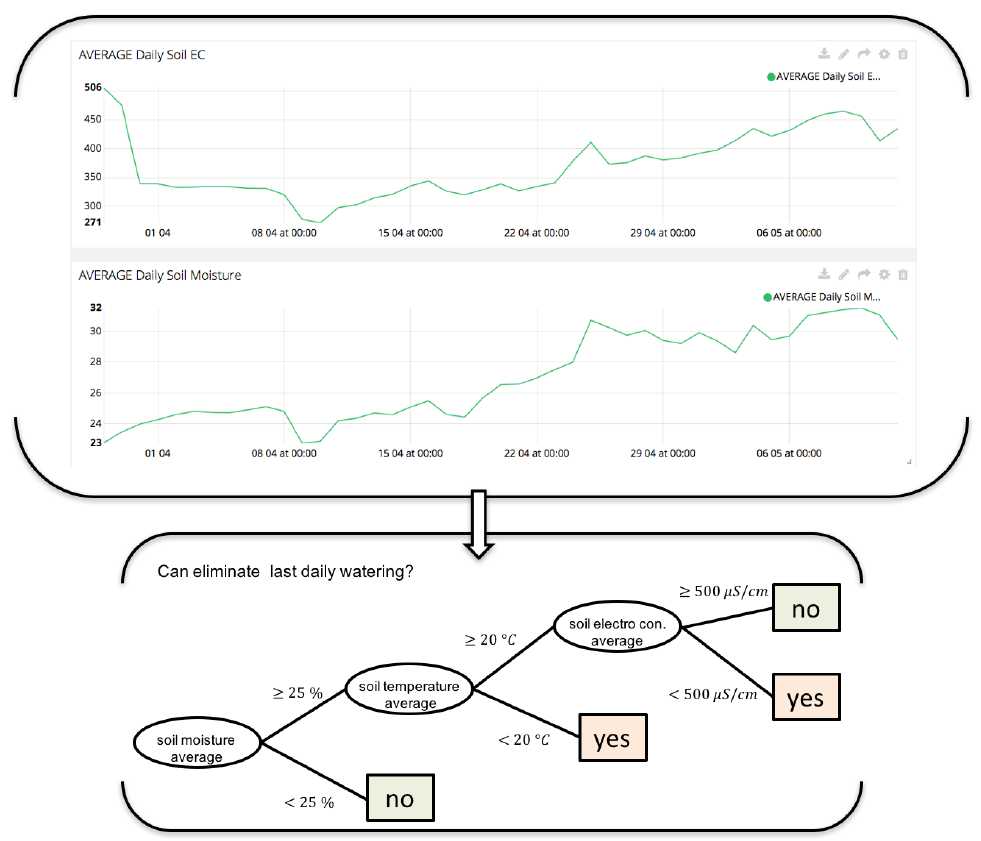
Figure 10. Decision Tree developed on irrigation control designed by agronomist and integrated on edge node. This decision tree aims to optimize water consumption. This new rule is designed by farmer observing the evolution of the data during the plant